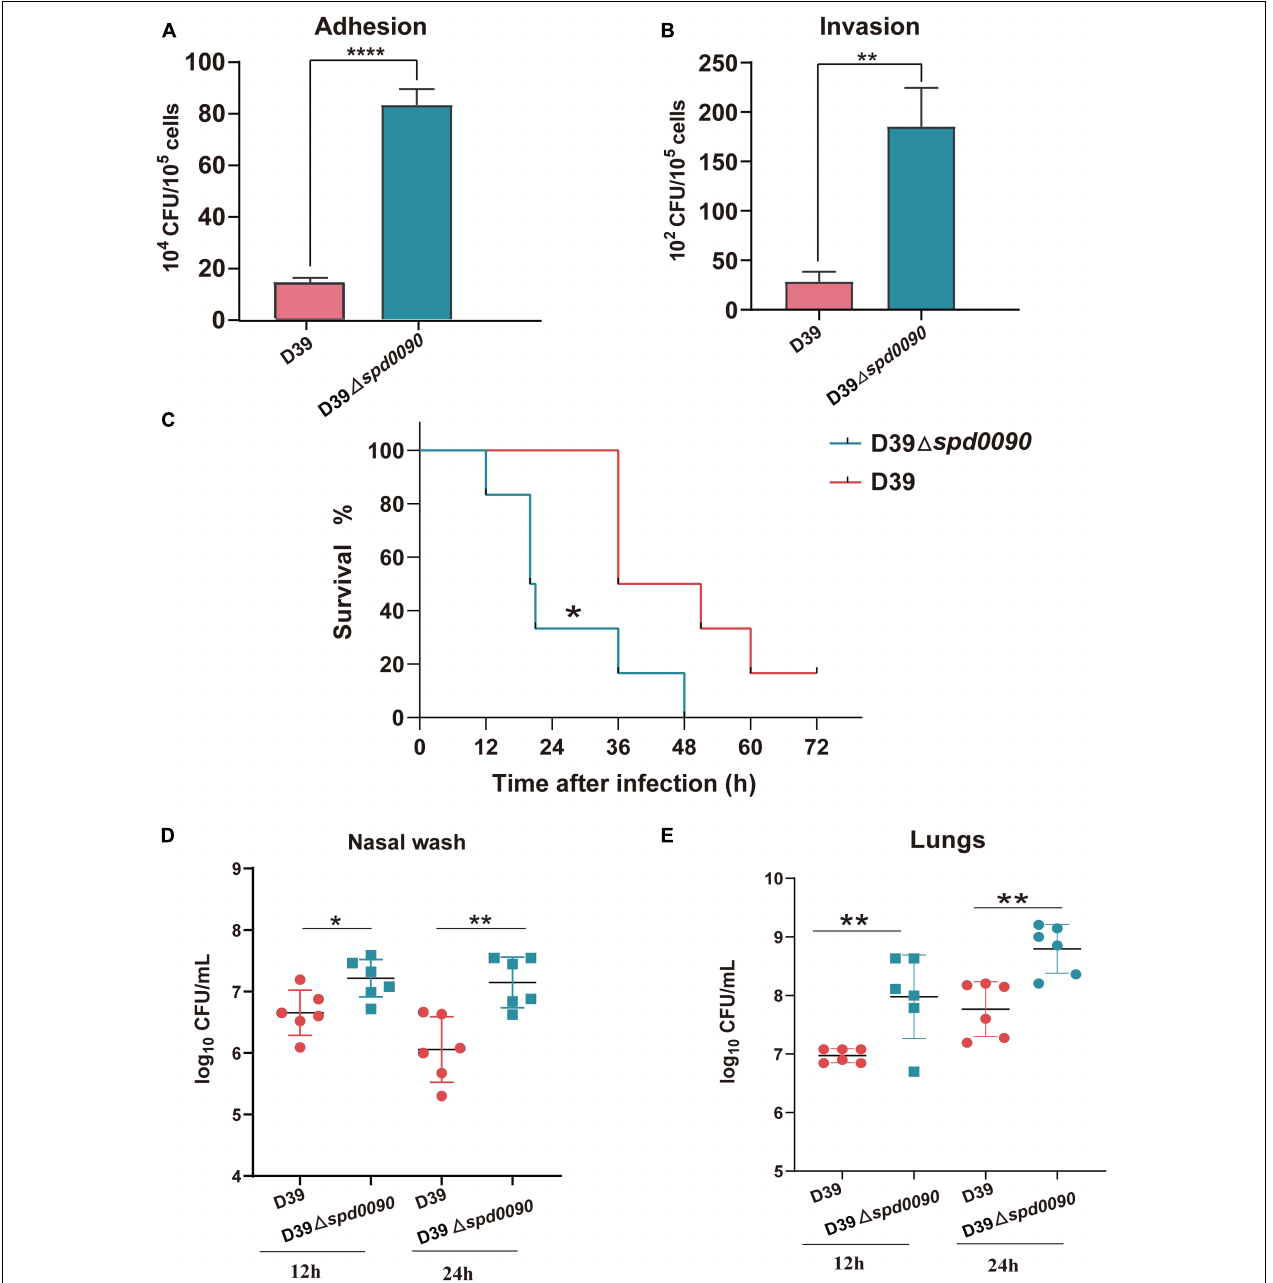
FIGURE 6 | SPD_0090 negatively regulates the virulence of S. pneumoniae. (A,B) The adherence and intracellular invasion ability of D39 and D39 (cid:49) spd0090 strains. (C) The survival curves of D39 or D39 (cid:49) spd0090 strains infected mice via nasal infection with 2.5 × 10 8 CFU/20 µ l. n = 6 animals per group. Survival was analyzed using the log-rank (Mantel–Cox) test between the D39 and D39 (cid:49) spd0090 strains. (D,E) Bacterial burdens of the D39 and D39 (cid:49) spd0090 strains in the nasal lavage solution and lungs of mice 12 or 24 h post-challenge. Horizontal lines represent median values. p < 0.05 for comparison by the Mann–Whitney test to the results for mice infected with the parental WT; n = 6 animals per group. Error bars represent the SEM. Data (adherence and intracellular) were analyzed by two-tailed, unpaired Student’s t -tests, and results are expressed as means ± the SD (* indicates p < 0.05, ** indicates p < 0.01, *** indicates p < 0.001, and **** indicates p <